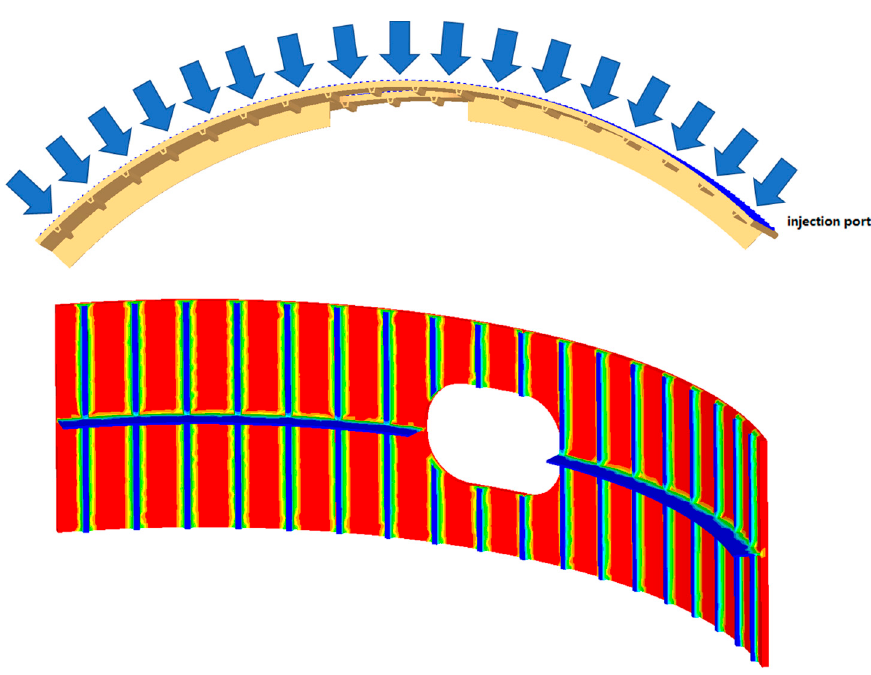
Figure 19. Injection case D for the fuselage section. Table 10. Fill times and injectability numbers for filling cases of the fuselage section.